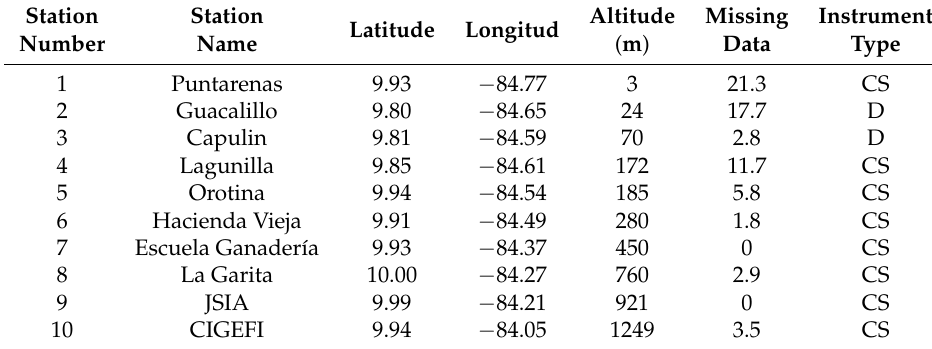
Table 1. List of stations according to Figure 1a, their locations, altitude, and percentage of missing data. CS: Campbell Scientific, D: